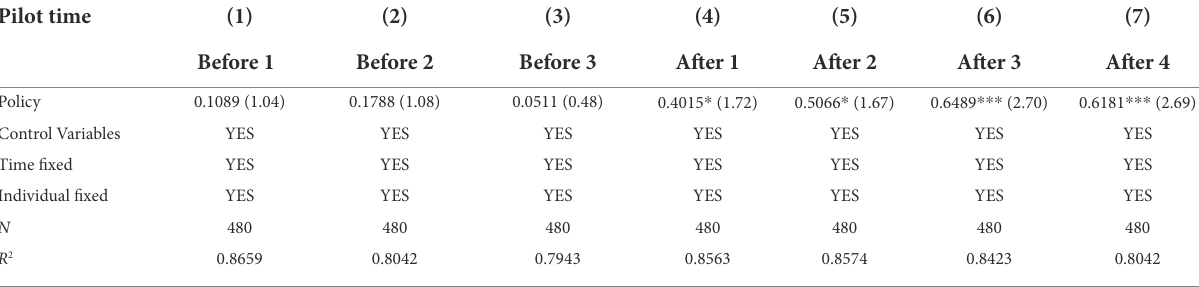
TABLE 3 Regression results of the total factor productivity parallel trend test.